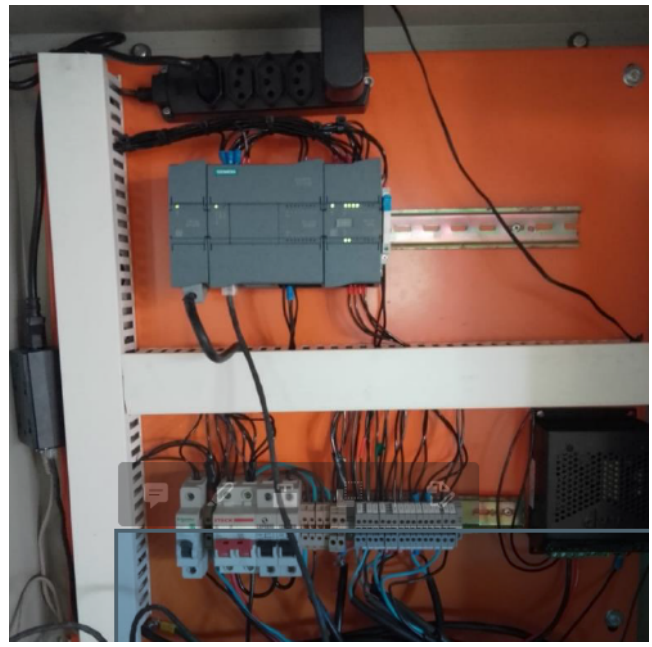
Figure 13. Control panel with Siemens controller. Source: Google